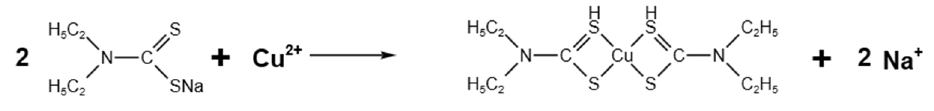
Figure 7. Principle of color reaction between DDTC and Cu 2+ .